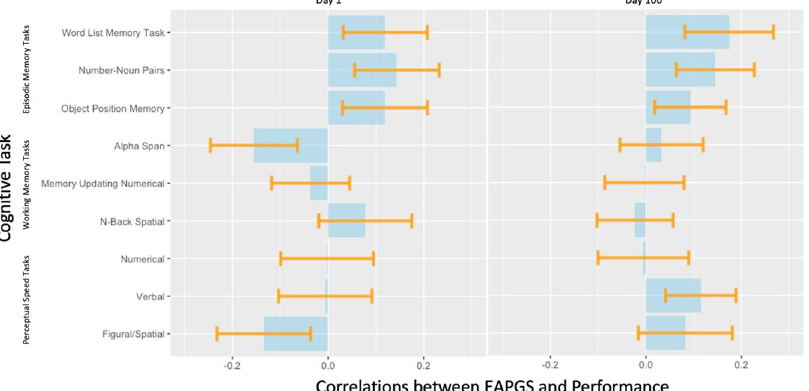
Fig. 4 Spearman correlations between EAPGS and performance at day 1 (top) and at day 100 of the practice period (bottom) on all cognitive tasks. The blue bars indicate Spearman correlation coef fi cients between EAPGS and test performance and orange lines indicate error bars (i.e., ± standard error). Spearman correlations were used to reduce the potential in fl uence of